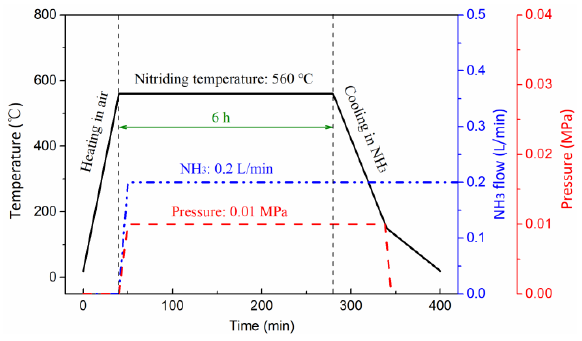
Figure 3. Schematic illustration of low-pressure gas nitriding used in this study.